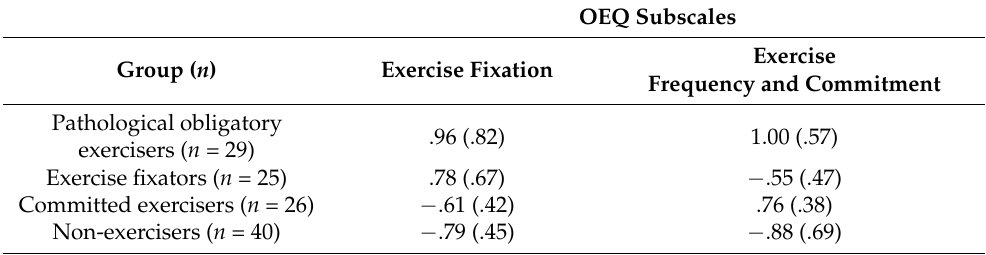
Table 2. Means, Standard Deviations, and Group Size ( n ) of Four Clusters on OEQ